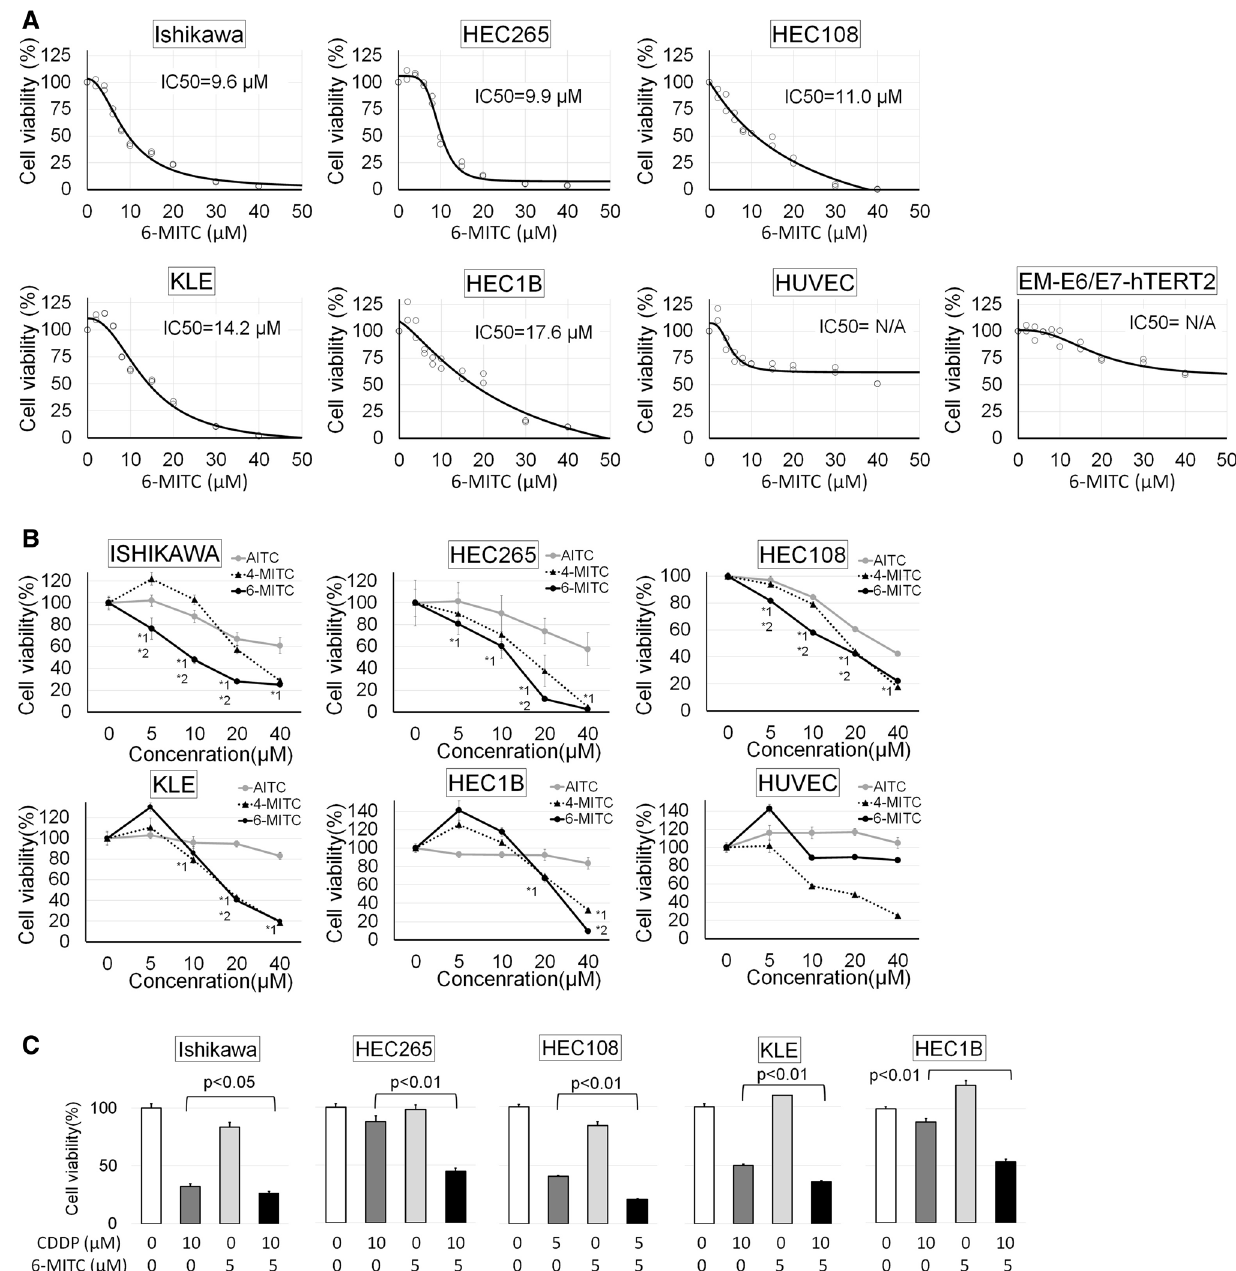
Fig. 1 A The 6-MITC dose-dependent cell viability curve. The cell viability at each dose was measured using the WST-1 assay in EMC cell lines, Ishikawa, HEC265, HEC108, KLE, and HEC1B, and normal cell lines, HUVECs, and EM-E6/E7-hTERT2. Cell viability curves were drawn using the 4-parameter logistic method. The calculated IC50 values of each cell line are expressed in the Figure. On the other hand, the effects of 6-MITC for HUVECs and EM-E6/E7-hTERT2 were too weak to calculate IC50 values. B The effects of 6-MITC, AITC, and 4-MITC on cell viability were examined using the WST-1 assay in EMC cell lines and HUVECs. 6-MITC significantly reduced cell viability compared with AITC and 4-MITC, dose-dependently, especially in Ishikawa, HEC265, and HEC108 cells. In contrast, 5 µM of 6-MITC significantly increased cell viability in KLE and HEC1B (p < 0.01). Unlike 4-MITC, 6-MITC and AITC did not reduce cell viability to below 80%. *1: significant reduc- tion (p < 0.05) of cell viability with each dose of 6-MITC compared with 0 µM of 6-MITC and the same dose of AITC. *2: significant reduction (p < 0.05) of cell viability with each dose of 6-MITC compared with 0 µM of 6-MITC and the same dose of 4-MITC. C: Effect of 5 µM 6-MITC addition on CDDP sensitivity in EMC cell lines using the WST-1 assay. The addition of 5 µM 6-MITC alone did not sufficiently reduce cell via- bility but significantly enhanced CDDP sensitivity. The effect was marked on HEC265 and HEC1B cells, which are less sensitive to CDDP. Cell viability is the percentage relative to that at 0 µM. Graphs indicate mean values, and error bars indicate standard deviations. These results were obtained from two ( A ) or three ( B and C ) independent experiments performed in octuplicate for every